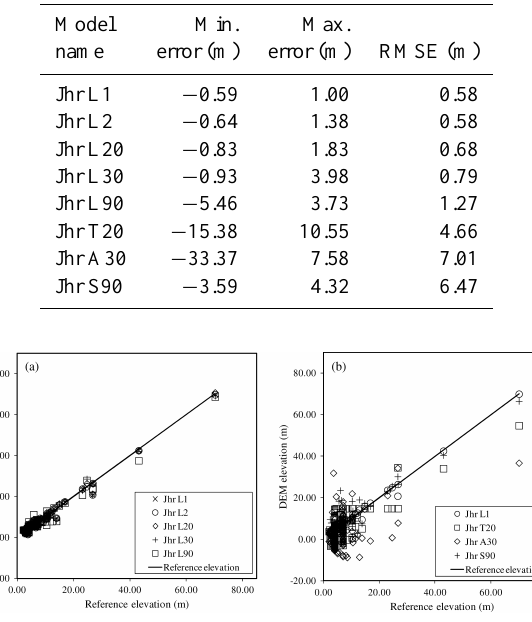
Figure 3. Comparison between GPS point elevations and elevations derived by the different DEMs: (a) lidar DEM at different resolution and (b) different sources of DEMs.